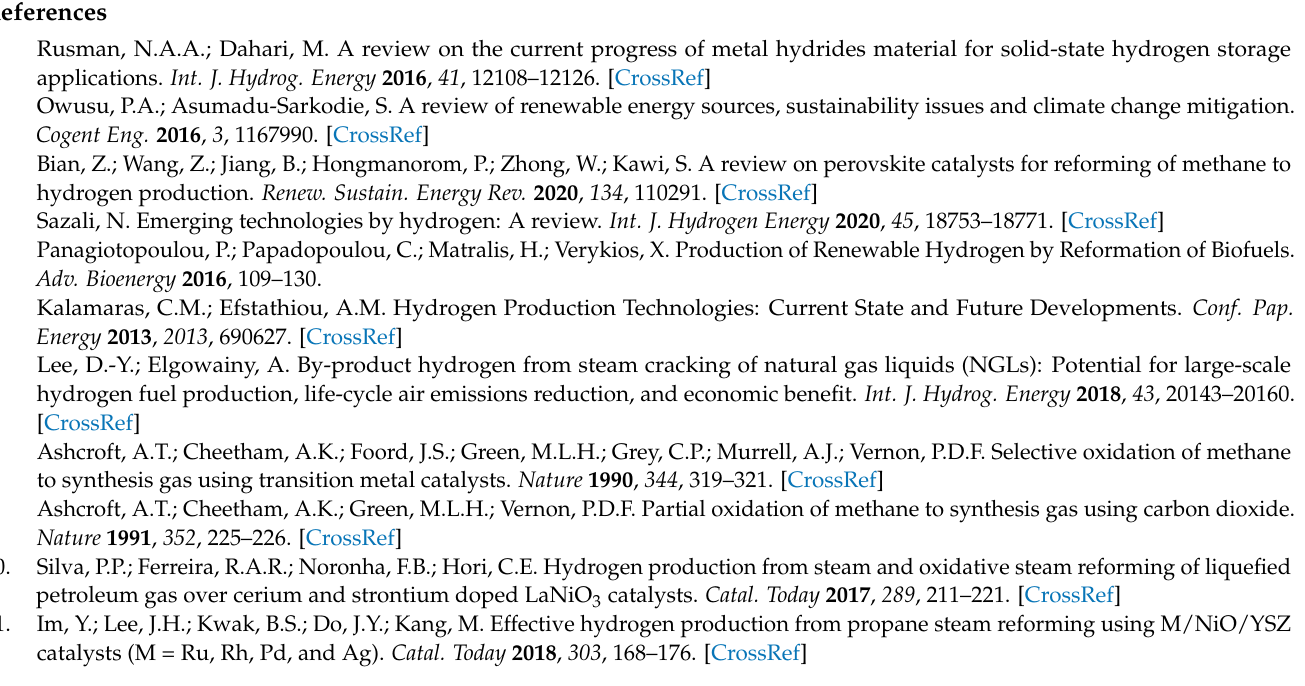
Table S1: Cell parameters of the crystalline phases detected by XRD for the as-prepared perovskite samples and the derived (used)